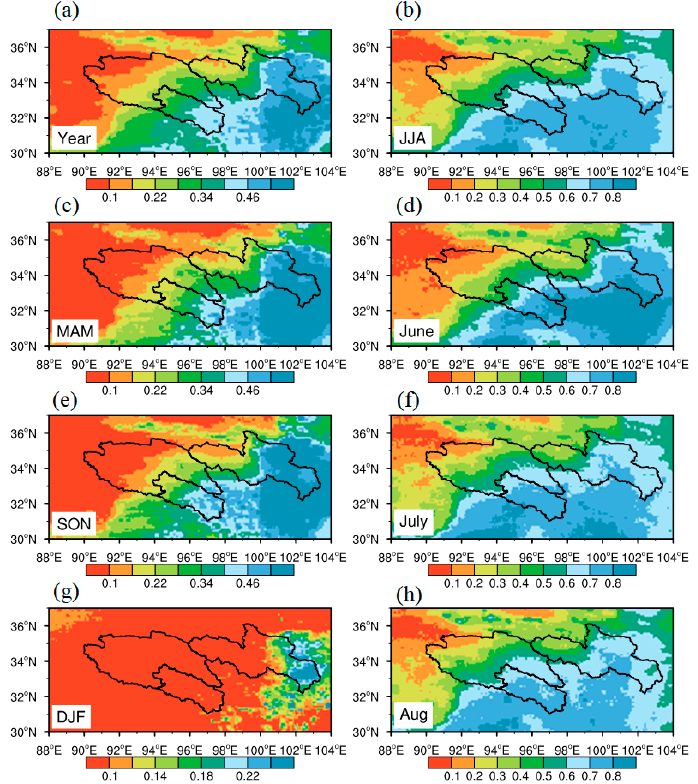
Figure 4. Precipitation occurrence ratio in ( a ) annual average, ( b ) June-July-August (JJA) average, ( c ) March-April-May (MAM) average, ( d ) June average, ( e ) September-October-November (SON) average, ( f ) July average, ( g ) December-January-Februrary (DJF) average, and ( h ) August average from 2001 to 2019.